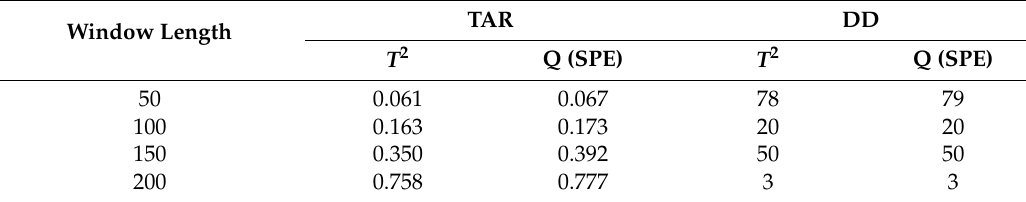
Table 6. Monitoring results on AG mill power draw using Method I.